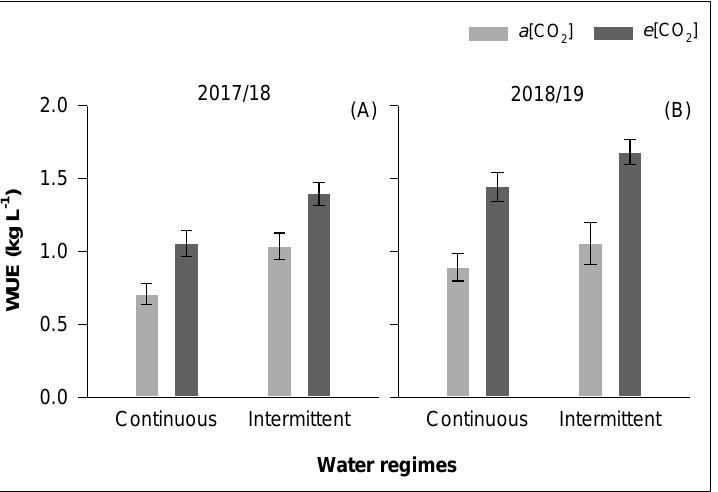
Figure 6. Effect of CO 2 concentrations { a [CO 2 ] = 400 μmol mol −1 and e [CO 2 ] = 700 μmol mol −1 } and water regimes (continuous vs. intermittent flood) on the water use efficiency of rice plants in 2017/18 ( A ) and 2018/19 ( B ) growing season. Error bars correspond to 95% confidence intervals.